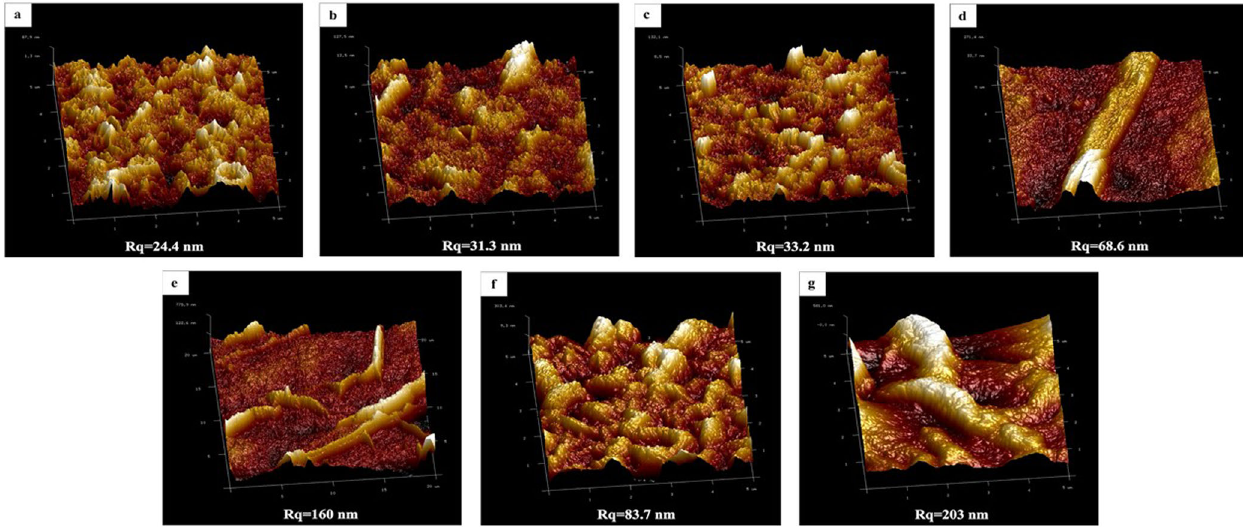
Fig. 5 AFM images of composite NF membrane. AFM images (scale bar: 5 μ m) of a TFC, b L-SCNF-0.01, c L-SCNF/Ag-0.01, d M-SCNF-0.01, e MSCNF/Ag-0.01, f H-SCNF-0.01 and g